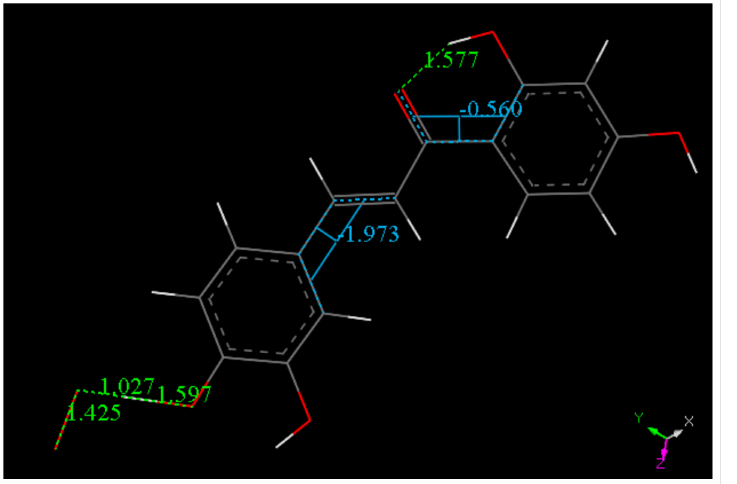
Figure 8. Converged DFT minimum of energy arrangement after geometry optimization for van der Waals separated (2.60 Å) superoxide and 4-H(hydroxyl) of Butein. Calculation includes water solvent and dispersion term Grimme. It is seen that H(4) is captured by superoxide (O–H distance 1.027 Å).